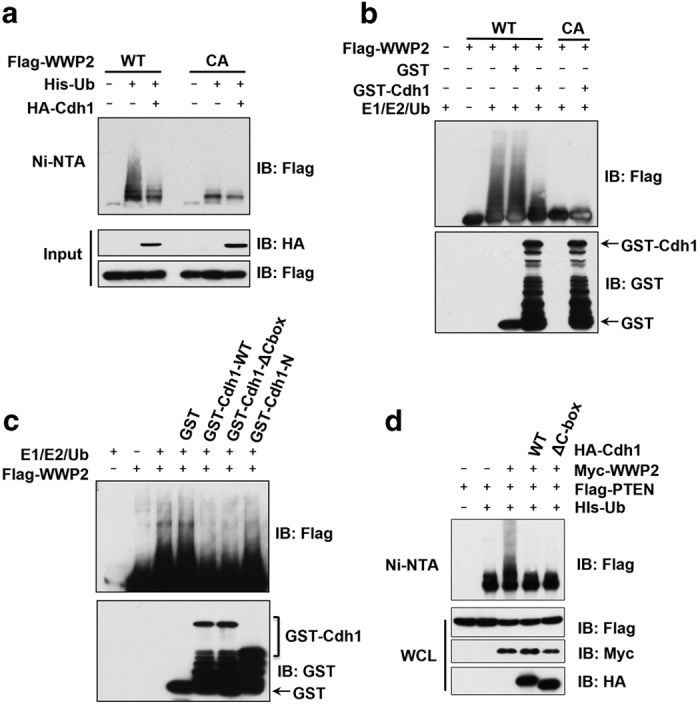
Cdh1 promotes the auto-inhibition of WWP2 E3 ligase. (a) Cdh1 suppresses WWP2 auto-ubiquitination in cells. Immunoblot (IB) analysis of whole-cell lysates (WCL) and subsequent Ni-NTA pull-down in 6 M guanidine-HCl-containing buffer derived from 293 T cells transfected with the indicated plasmids. The cells were pretreated with 10 μM MG132 for 10 h before collecting. (b) Purified GST-Cdh1 inhibits WWP2 auto-ubiquitination in vitro. Bacterially expressed and purified GST-Cdh1 was incubated with E1, E2 and ubiquitin and anti-Flag immunoprecipitates derived from HeLa cells transfected with Flag-WWP2-WT or Flag-WWP2-C838A (CA) constructs as indicated at 30 °C for 15 min. The ubiquitination reaction products were recovered to perform GST pull-down analysis with the indicated GST-fusion proteins then resolved by SDS–PAGE and probed with the indicated antibodies. (c) Purified GST-WT-Cdh1 and GST-ΔC-box-Cdh1 inhibits WWP2 auto-ubiquitination in vitro. Indicated bacterially purified GST-Cdh1 proteins were incubated with E1, E2 and ubiquitin and anti-Flag immunoprecipitates derived from 293 T cells transfected with Flag-WWP2 constructs as indicated at 30 °C for 15 min. The ubiquitination reaction products were recovered to perform GST pull-down analysis with the indicated GST-fusion proteins then resolved by SDS–PAGE and probed with the indicated antibodies. (d) Cdh1 suppresses the E3 ligase activity of WWP2 towards ubiquitinating PTEN in cells. IB analysis of WCL and subsequent Ni-NTA pull-down in 6 M guanidine-HCl-containing buffer derived from 293 T cells transfected with the indicated plasmids. The cells were pretreated with 10 μM MG132 for 10 h before collecting. PAGE, polyacrylamide gel electrophoresis.